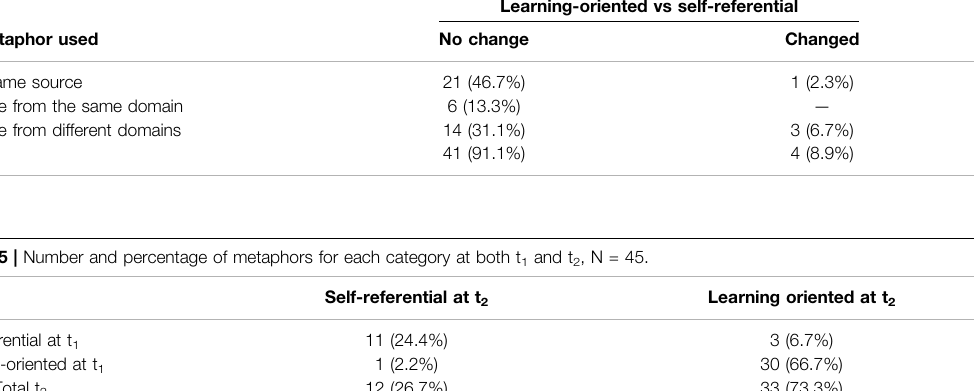
Learning-oriented vs self-referential